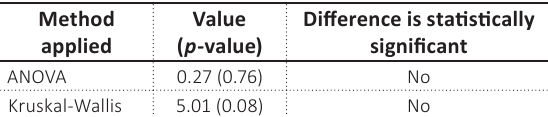
Table 3. ANOVA and Kruskal-Wallis test results for ESG and conventional indices (case of returns)